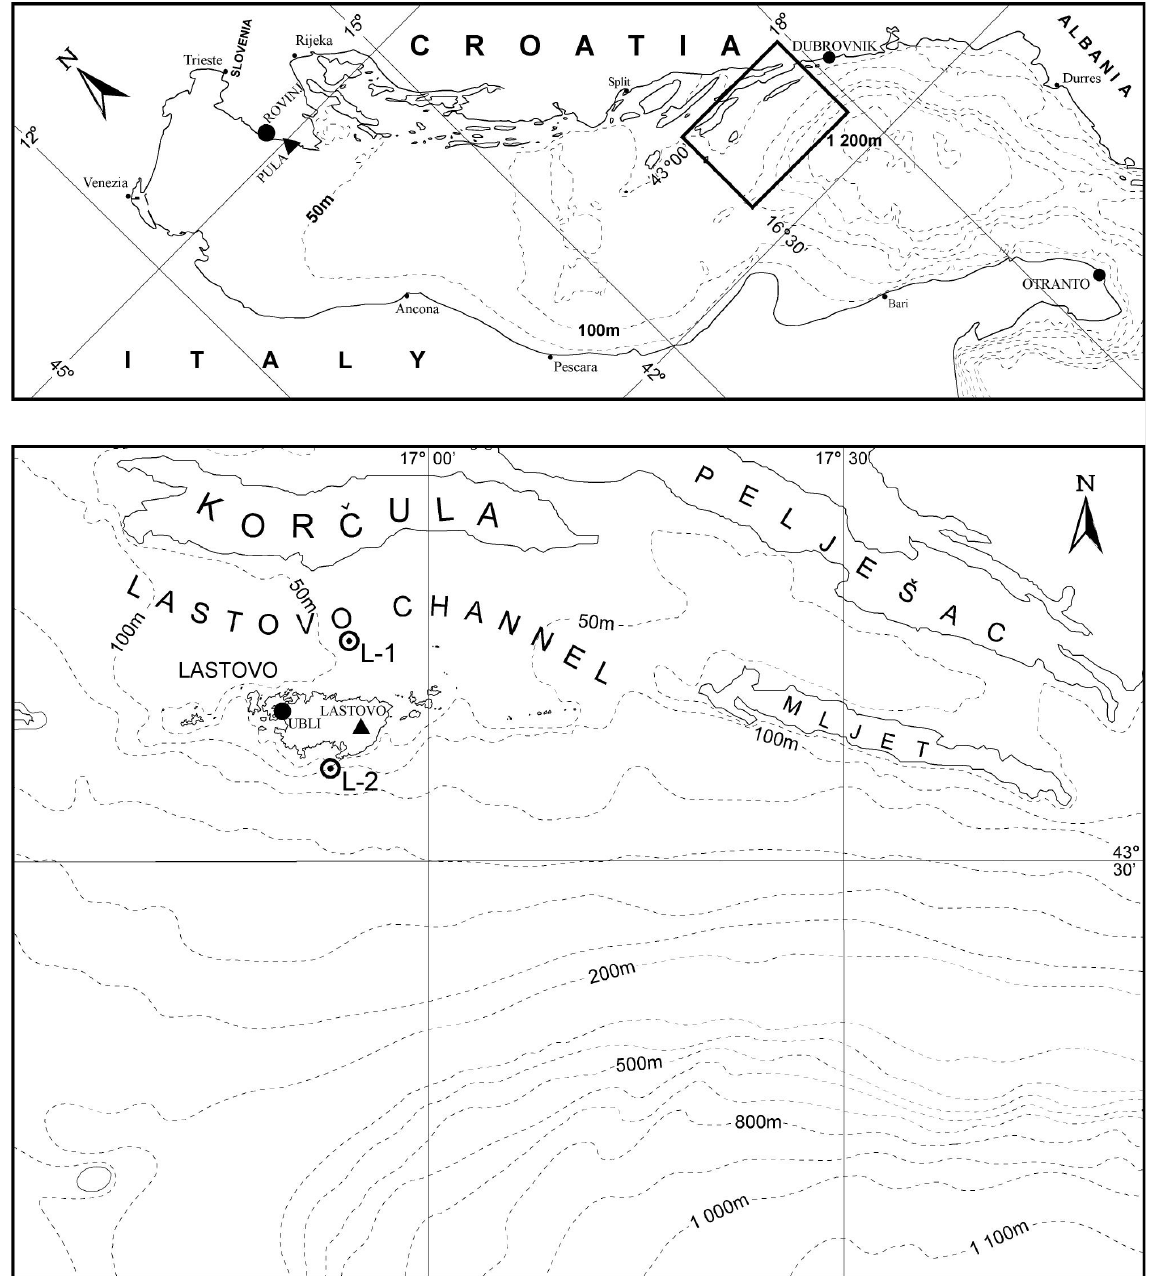
Fig. 1. Bathymetric map of the Adriatic Sea. The open circles indicate the locations of moorings, black circles the tide-gauge stations and triangles the meteorological